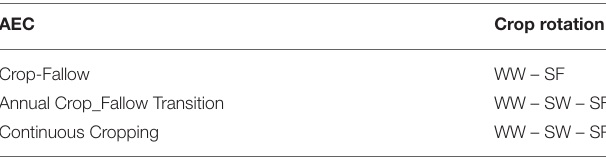
TABLE 1 | Dryland cropping systems used in each agroecological class (AEC) of the Inland Pacific